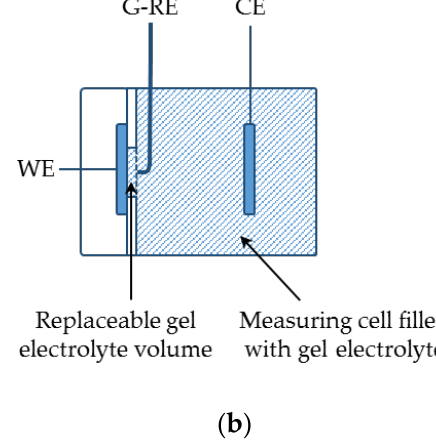
Figure 1. Schematic setup of the three-electrode configuration for polarization measurements in ( a ) aqueous solution (standard setup) and ( b ) gel electrolyte with WE = working electrode - test sample, RE = reference electrode - Ag/AgCl saturated KCl, CE = counter electrode - platinum sheet, HL = Haber-Luggin capillary, G-RE = reference electrode - plati- num